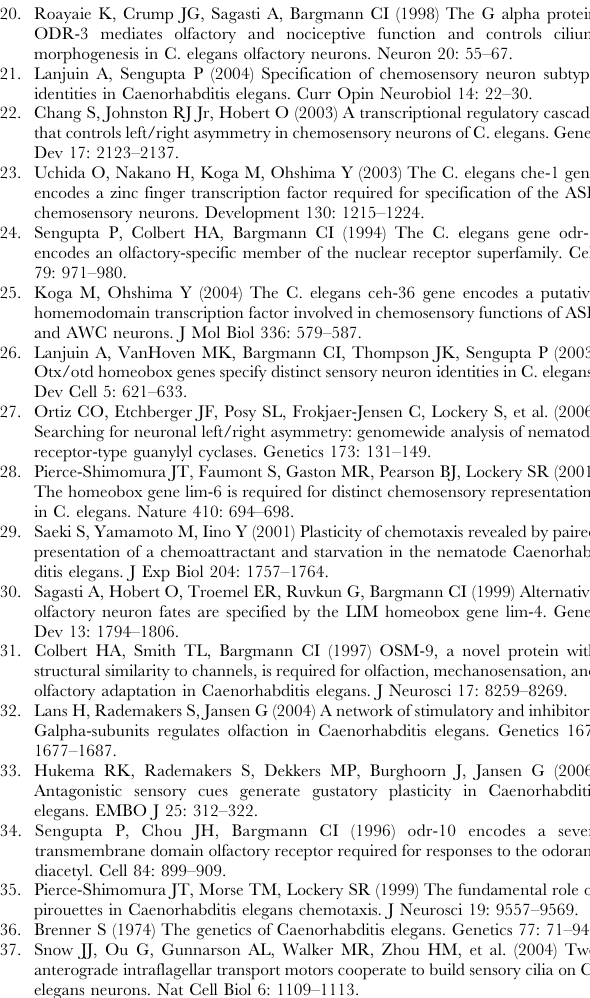
Figure S3 Effect of plate composition on NH 4 Ac